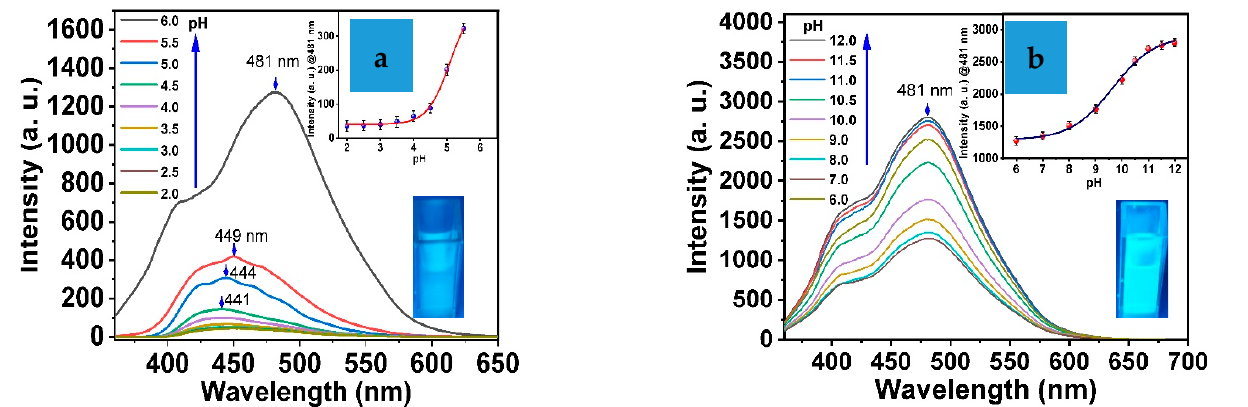
Figure 2. ( a ) Absorbance spectra of IXZD at various pH values; ( b , c ) the absorbance of the IXZD versus pH.